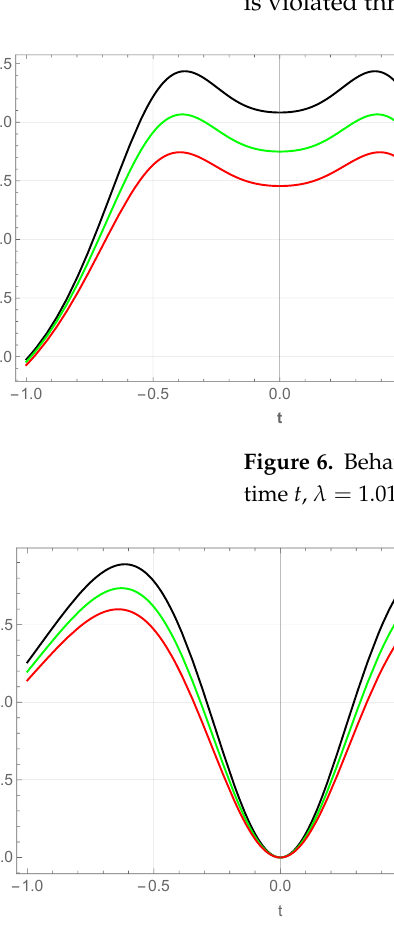
Figure 7. Behavior of Gauss–Bonnet invariant ( left panel ) and energy conditions ( right panel ) versus cosmic time t , α = − 0.30, β = 0.15 and λ =